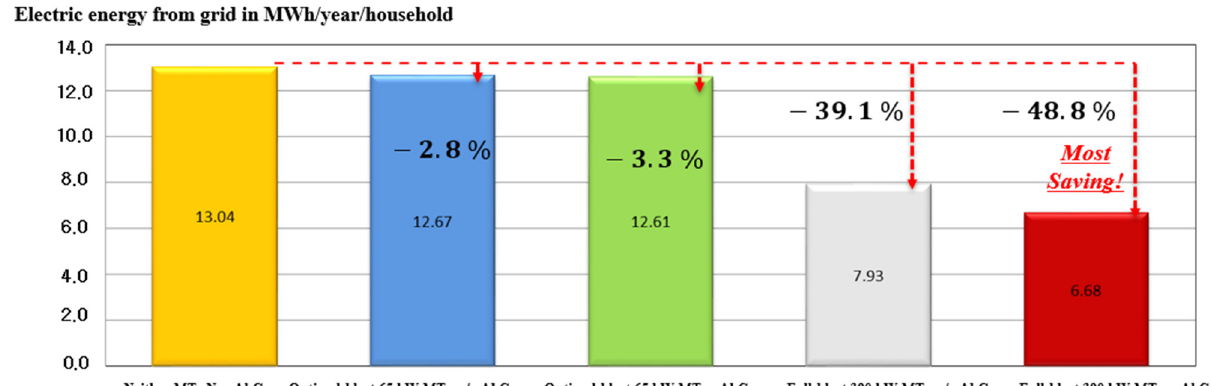
Figure 11. Electric output (full-blast power) and chilled air output (cooling demand) for Capstone MTs; 1 August 2013 (scenario 2).